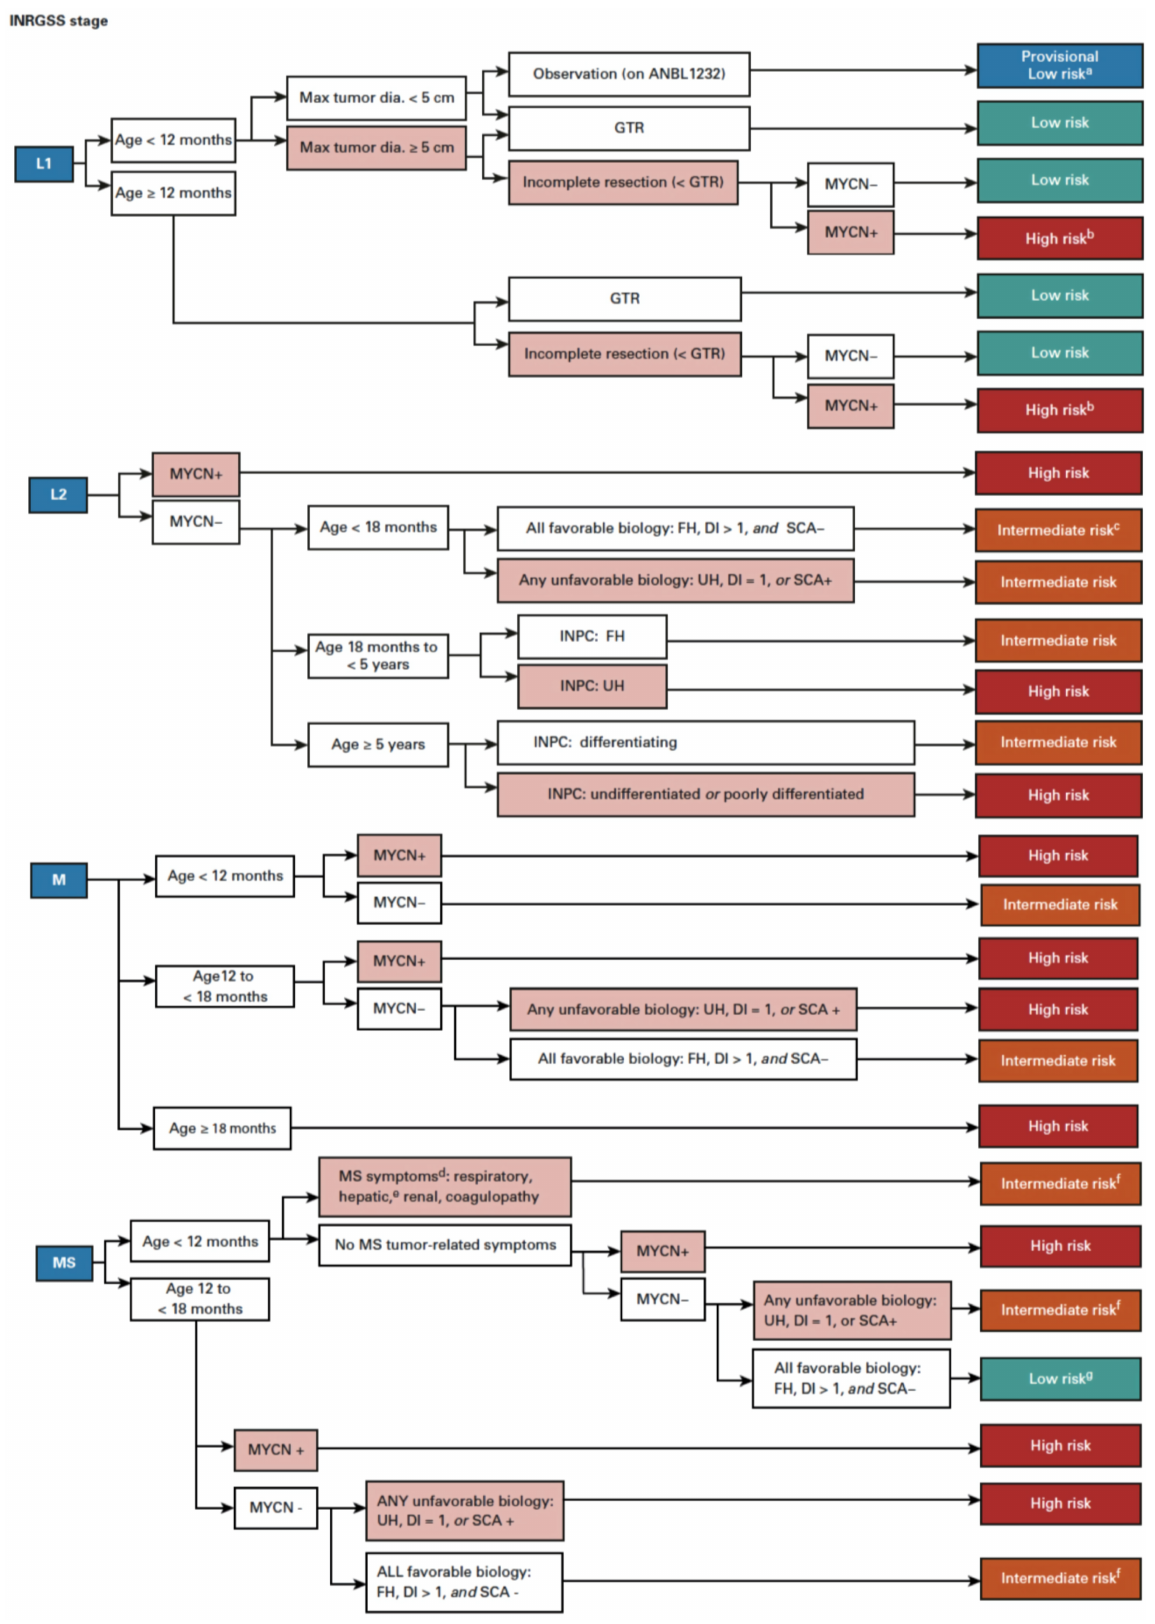
Figure 2. Children’s Oncology Group revised neuroblastoma risk classification system. For detailed explanation of the revised classification system, please see Ref. [8]. (Irwin M. et al., 2021